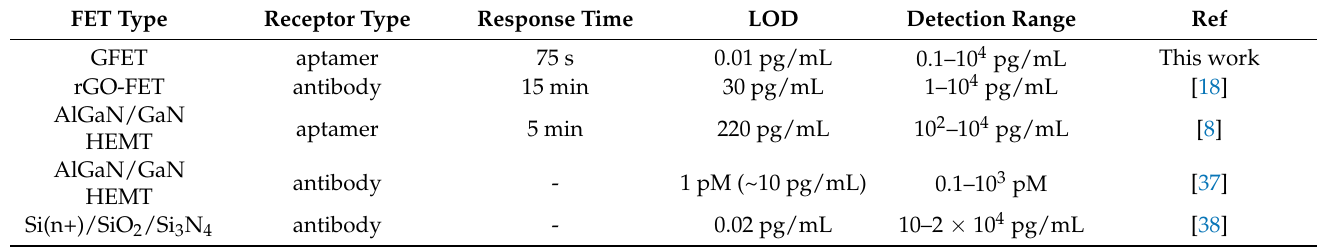
Table 3. FET-based sensors for NT-proBNP.